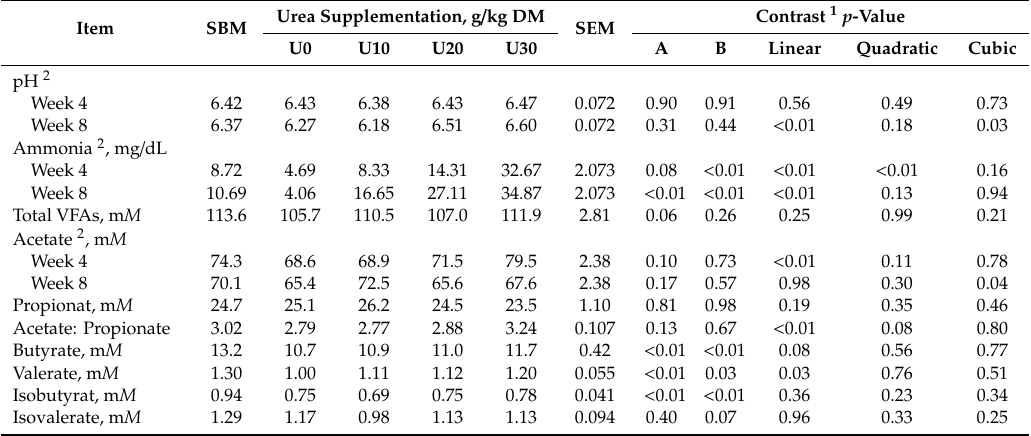
Table 2. E ff ects of urea supplementation on rumen fermentation characteristics in fattening